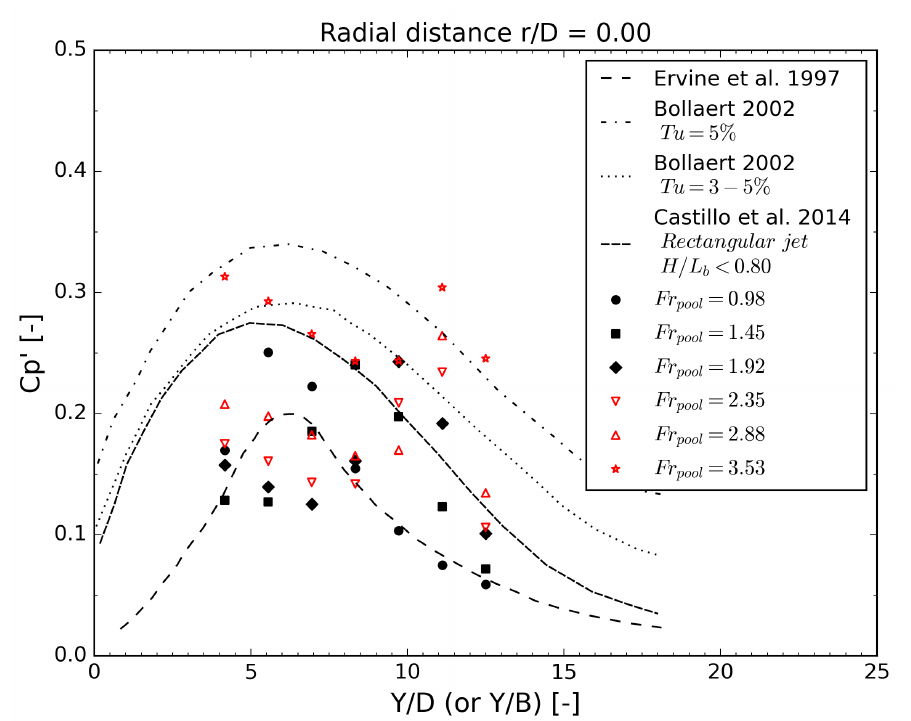
Figure 7. Fluctuating dynamic coefficient Cp (cid:48) [-] as a function of the pool depth ratio Y / D —at a radial distance r / D = 0.00—Jet break-up length ratio H / L b ≤